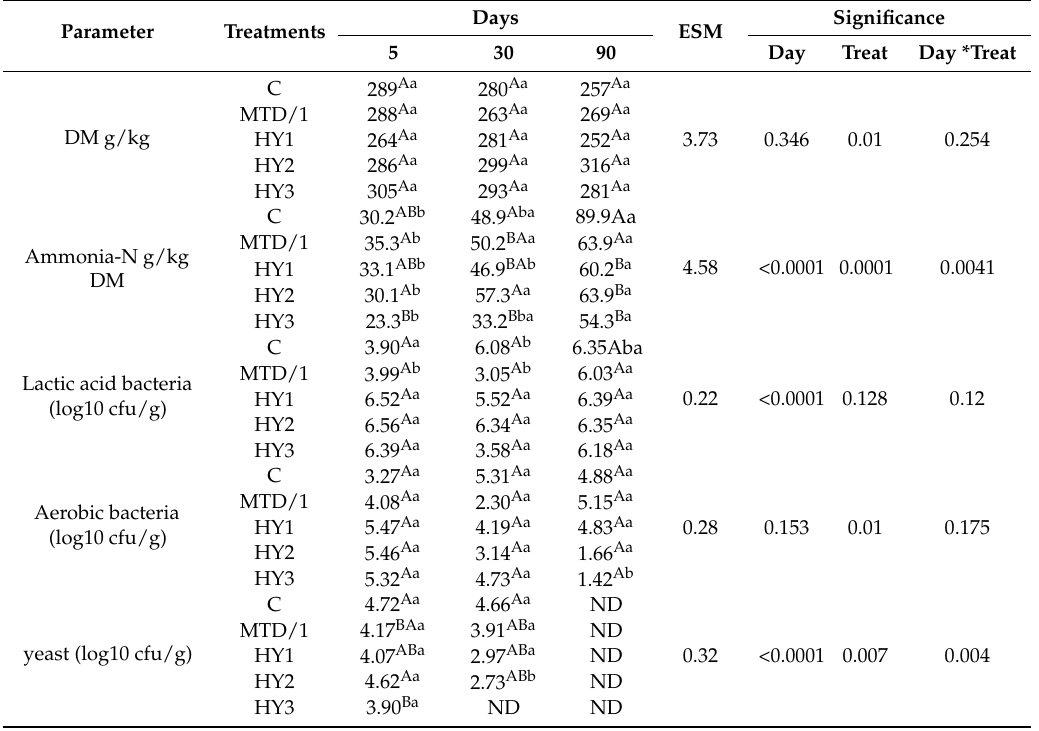
Table 4. Effects of LAB inoculant on DM, Ammonia-N and microbial counting of Napier grass ensiling for 90